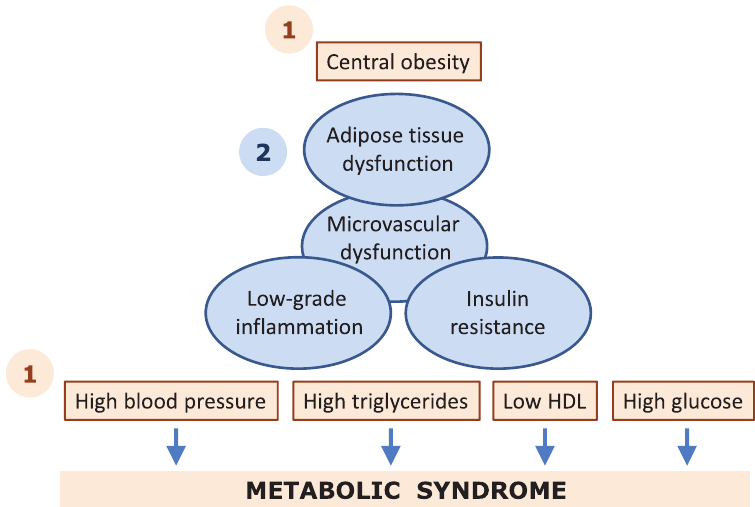
Figure 1. Schematic representation of the metabolic syndrome. The components that are used to define the metabolic syndrome are indicated in light brown. The underlying metabolic derangements are indicated in blue. Interventions can be targeted at the level of one or multiple individual components (indicated with 1) or at the potential underlying causes of the metabolic syndrome (indicated with 2). We have proposed that microvascular dysfunction is an early functional pathway that connects adipose tissue dysfunction to insulin resistance and resulting metabolic derangements, but this is beyond the scope of this review 9 . Abbreviations: HDL, high-density